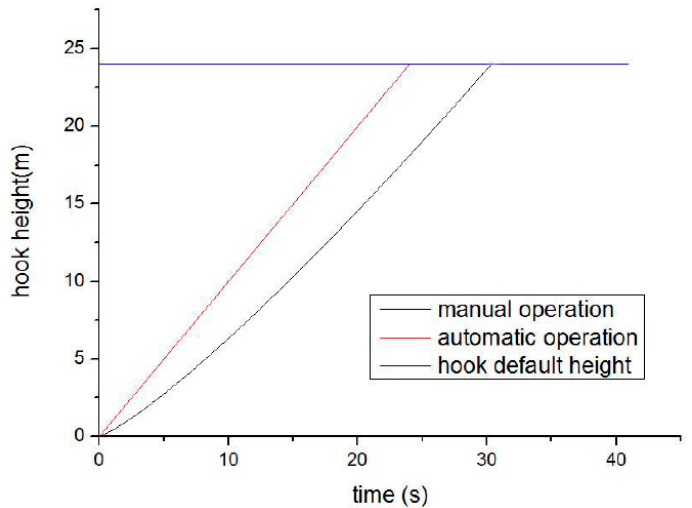
Figure 15. The hook hike motion curve of automatic and manual operation.